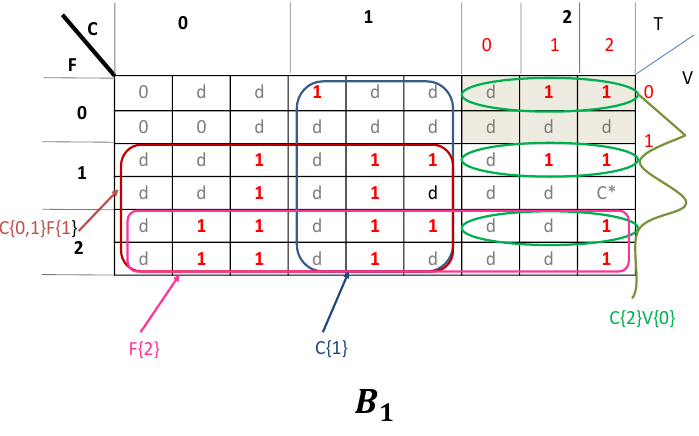
Fig. 4. A multi-valued-Karnaugh-map representation of 𝑩 (introduction of party bans), a translation of Table 3 in Hartmann and Kemmerzell (2010), with loops covering the prime implicants of the asserted part { } of 𝑩 assuming C* = 𝑩 𝒍